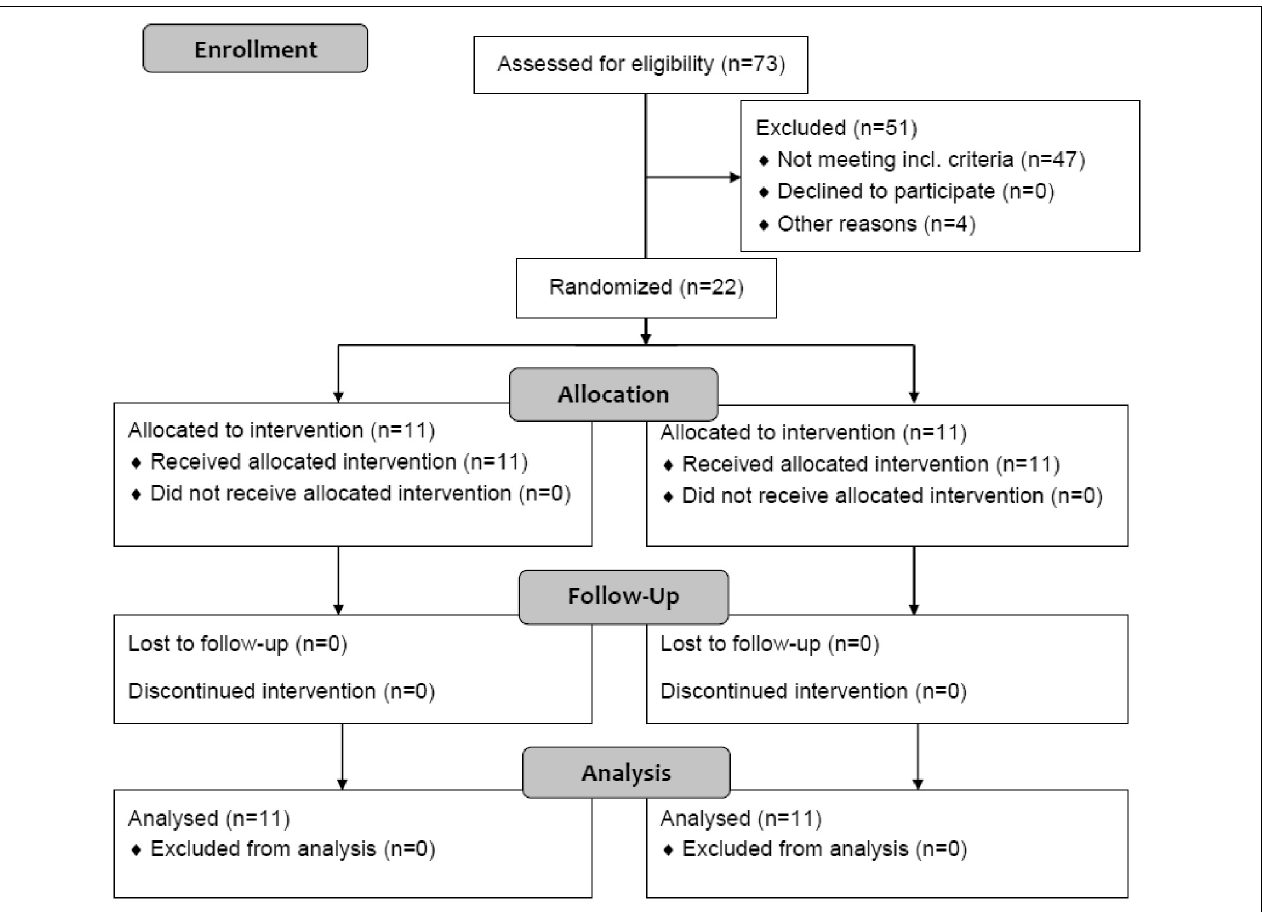
FIGURE 1 | A CONSORT randomized trial flow diagram.